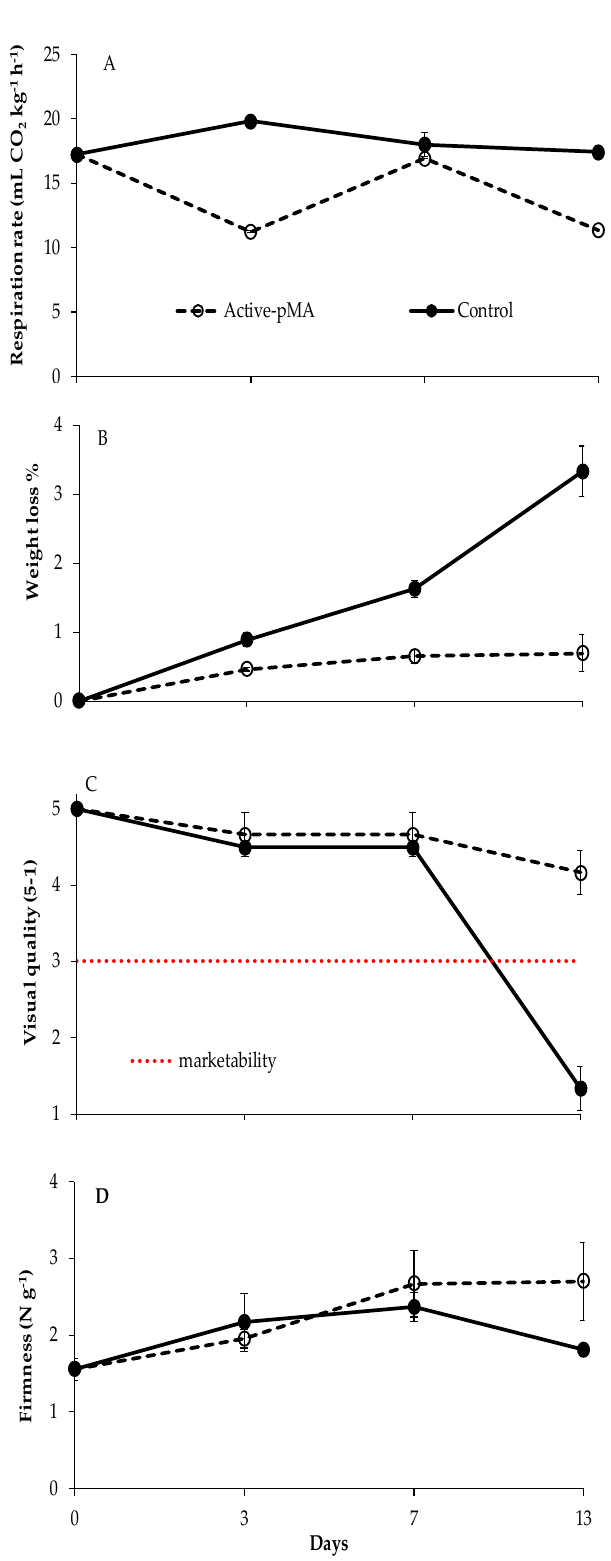
Figure 4. Changes in respiration rate ( A ), weight loss ( B ), visual quality ( C ) and firmness ( D ) in blueberries (cv Rebel) stored in Active-pMA or in air (Control) for 13 days at 8 ◦ C. Data are mean values ( n = 3) ± standard